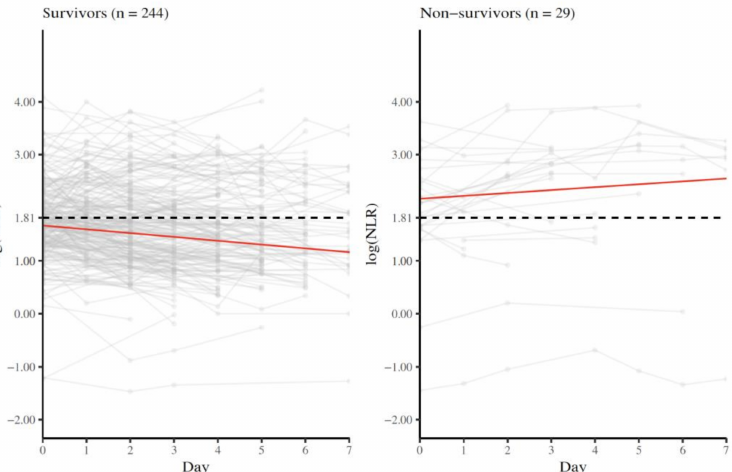
Figure 2. Trajectory plot of NLR measurements in survivors and non-survivors: n = number of patients. Each grey line indicates an individual patient. The median intercept and the slope of each group obtained from the summary measure analysis are displayed in red. The black, dashed line indicates the cut-off value of log (1.81), corresponding to a NLR of 6.11, as suggested by Cai et al.